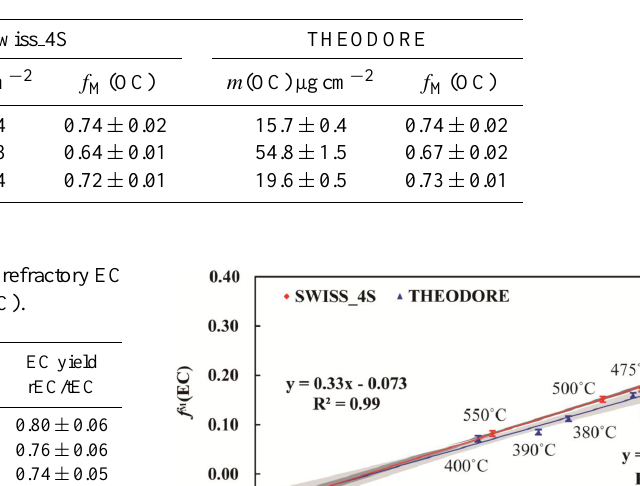
Table 3. Comparisons of the carbon masses ( m (OC)) and fraction of modern of OC ( f M (OC)) obtained with the present thermal-optical method (Swiss 4S) and thermal method (THEODORE).